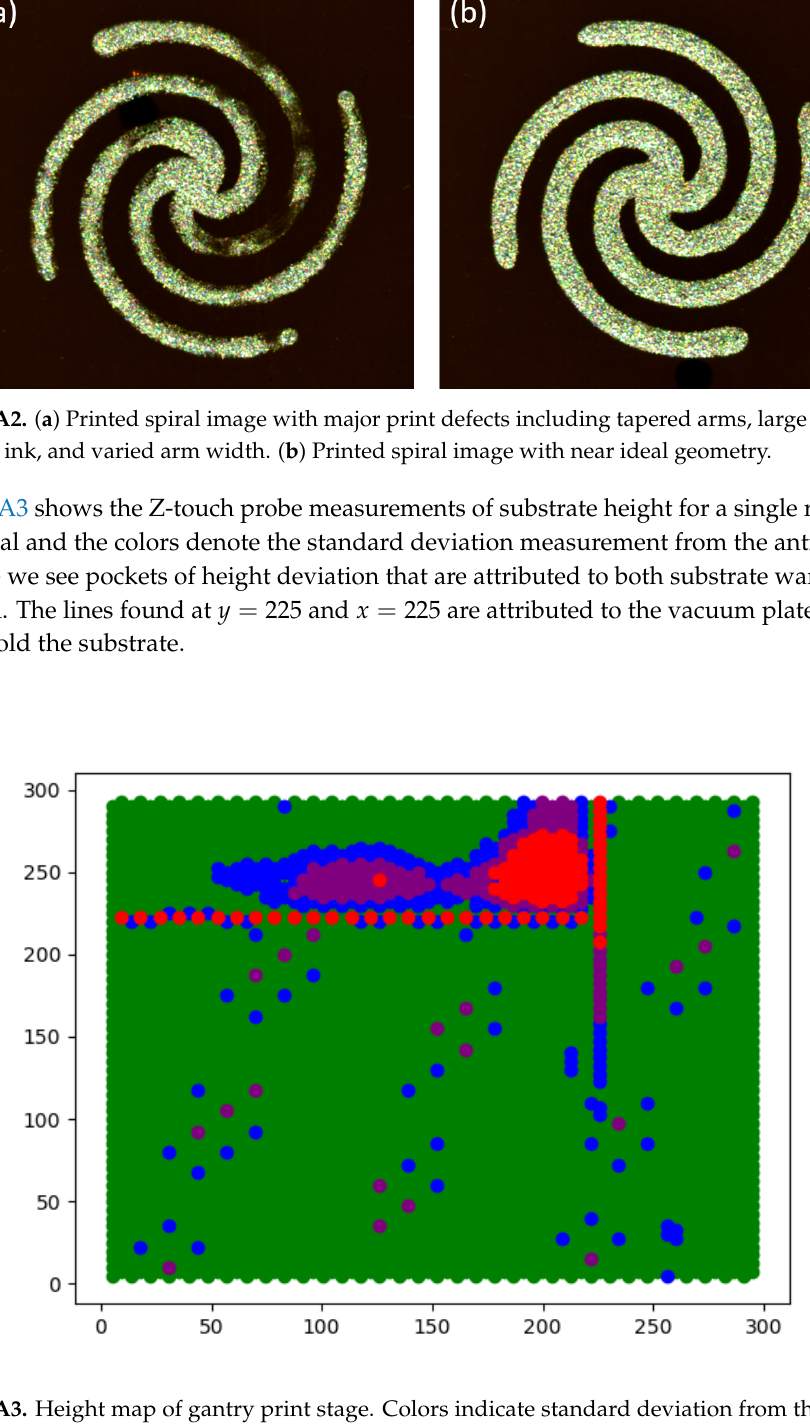
Figure A3. Height map of gantry print stage. Colors indicate standard deviation from the expected height of the point. Expected value (green), 1 σ (blue), 2 σ (purple), ≥ 3 σ